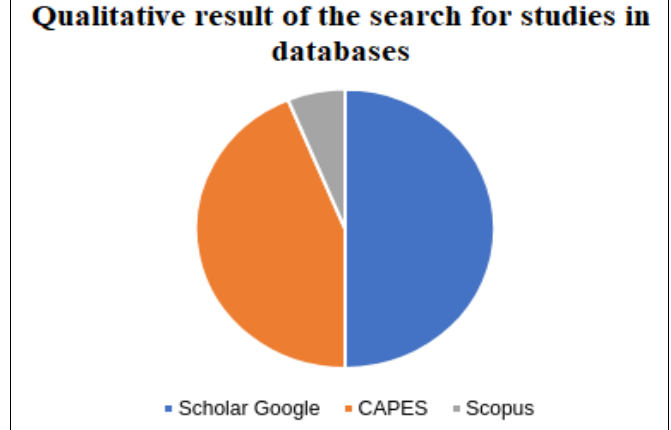
Figure 2: Graphical representation of the result of the search for studies in the databases.